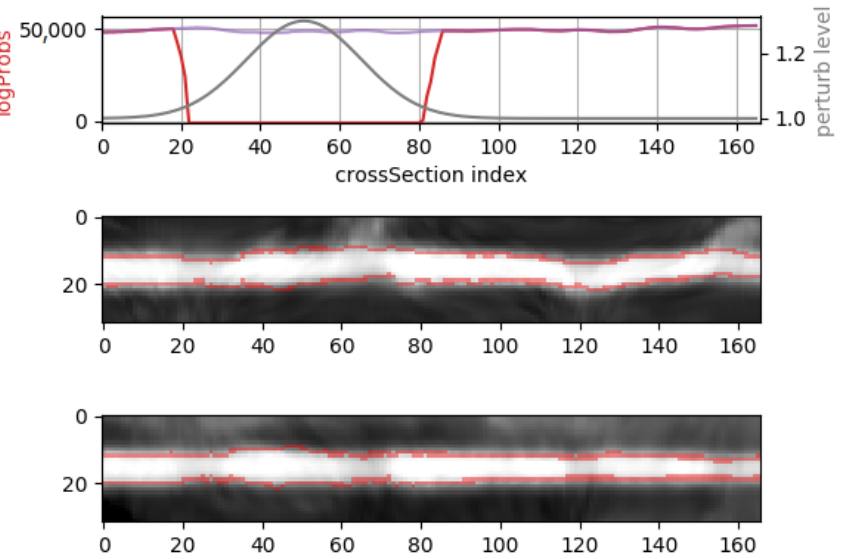
Figure 13. Whole vessel-segment prediction using a sliding window approach and the proposed architecture. A zooming perturbation with a known severity variation (top plot, gray signal) is applied (note that zoom level 1.0 × is an identity transform). The resulting log-prob signal (top plot, red signal) dips whenever the perturbation is severe enough, compared to the original log-prob signal in the absence of any perturbation (top plot, purple signal). The bottom 2 plots display two lateral views of the vessel segment (2 projections on different axes), with the perturbed mask contour